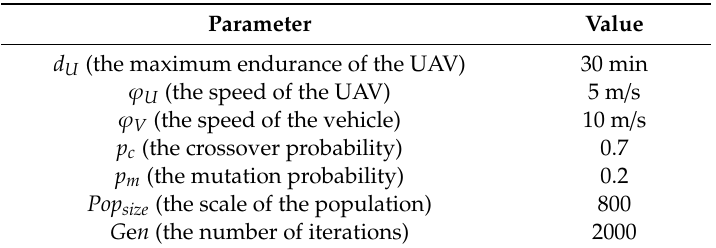
Table 1. Relevant parameters of the experiments.